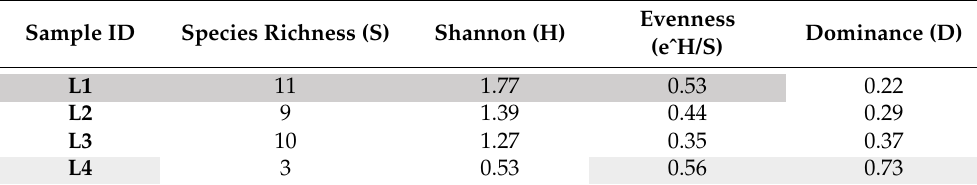
Table 2. Diversity indices for cultivable fungal diversity after standard freezing incubation. The highest and lowest values are highlighted for reference.